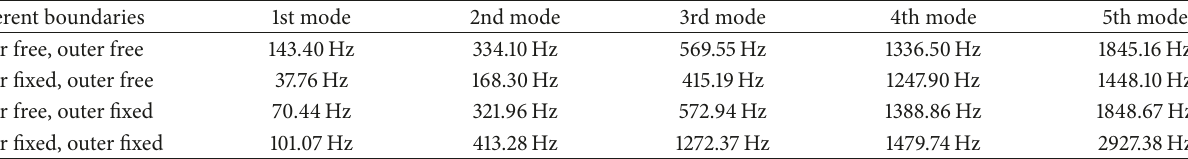
Table 3: Comparison of free vibration by FEM for four type boundaries.